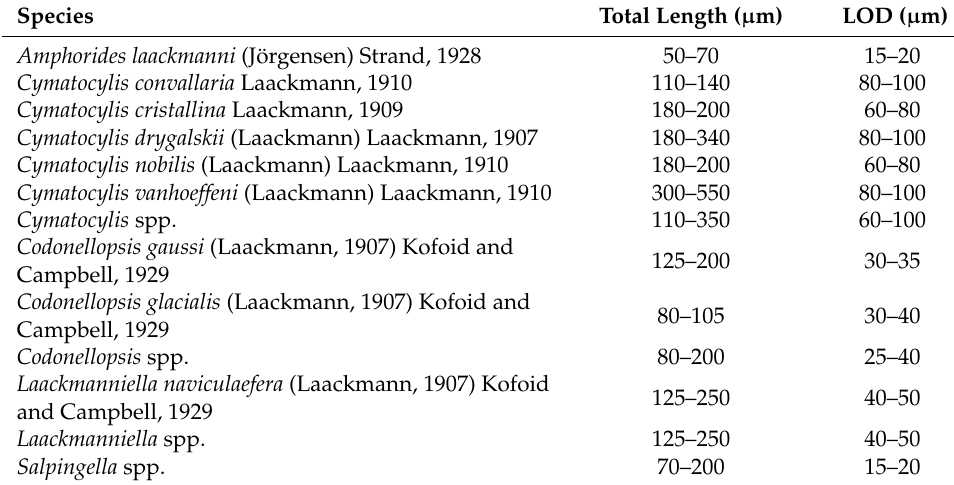
Table 1. List of tintinnid species, ranges of total lorica length, and lorica oral diameter (LOD). Species Total Length ( µ